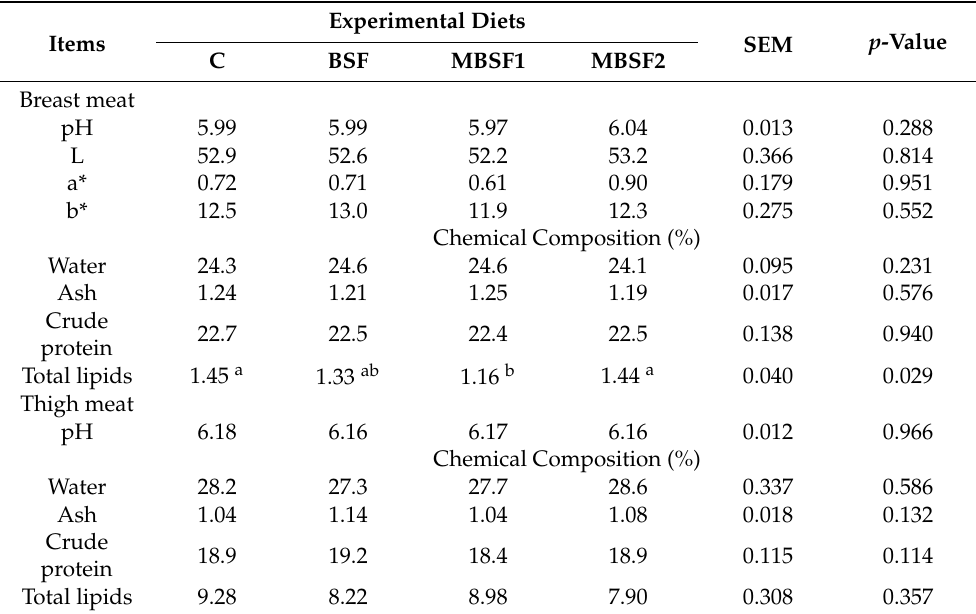
Table 6. Effect of black soldier fly larvae fat on meat quality traits and chemical composition of broiler chickens (n =